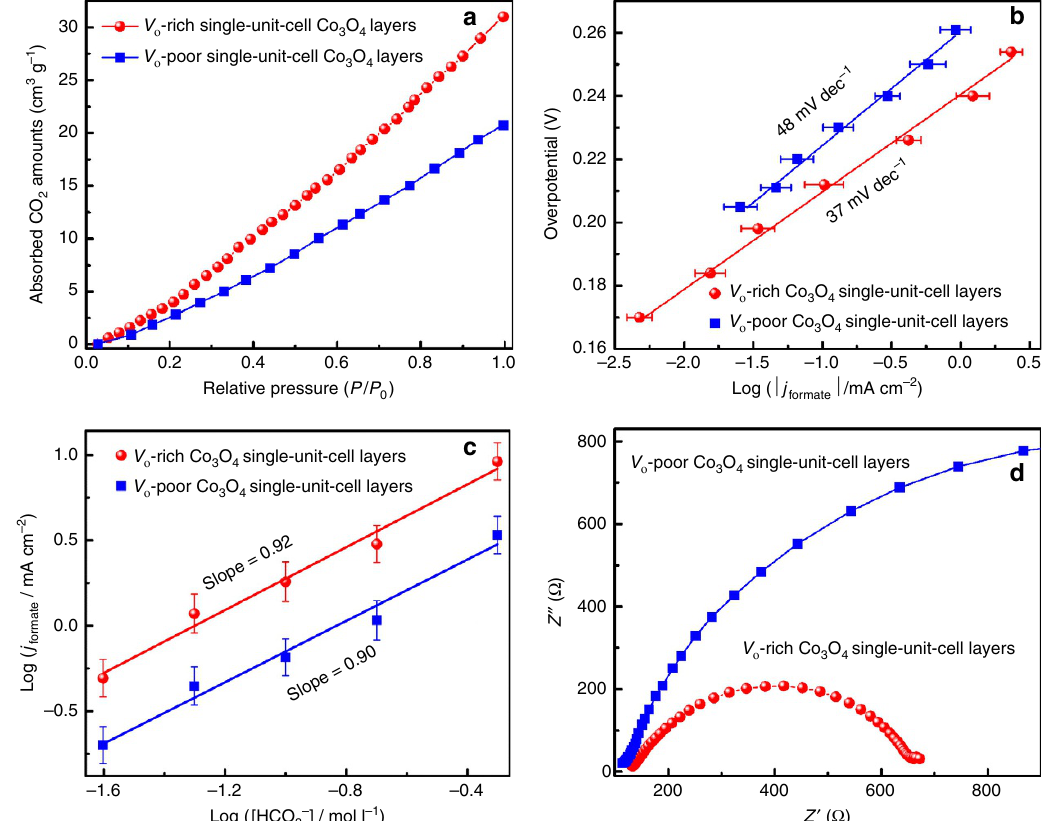
Figure 4 | Comparison of CO 2 adsorption amount, Tafel plots and electrokinetics. ( a ) CO 2 adsorption isotherms, ( b ) Tafel plots, ( c ) partial current density of formate production versus HCO (cid:2) concentration at a constant potential of (cid:2) 0.87V versus SCE and ( d ) electrochemical impedance spectra for 3 the V o -rich and V o -poor Co 3 O 4 single-unit-cell layers. The error bars in b and c represent the s.d.’s of five independent measurements of the same